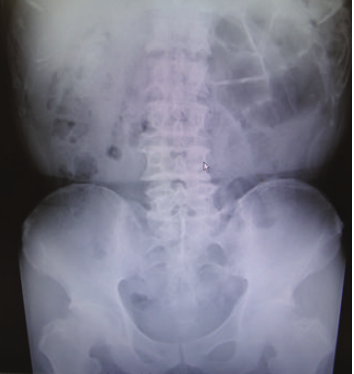
Figure 1: A radiograph shows the dilated small bowel in the upper quadrant.